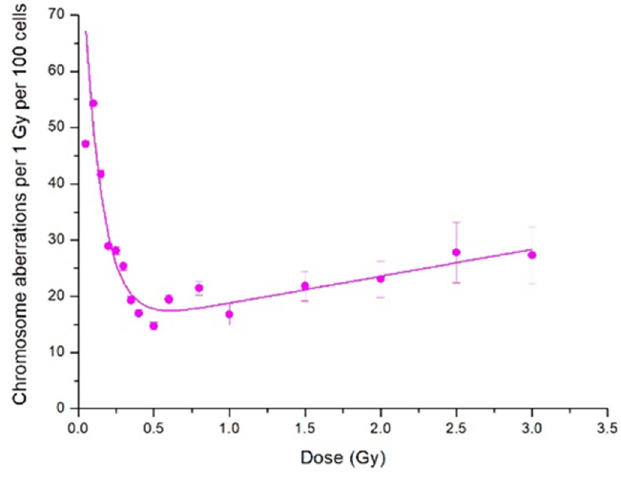
Figure 2. Yield of CA in CHO-K1 cells normalised per proton dose. Points are experimental data, and lines show our fits to the IR model.